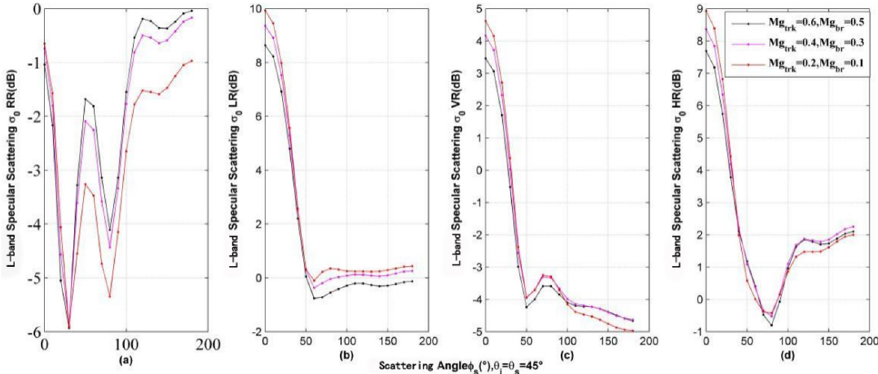
Figure 7. Specular scattering properties of various polarization for different vegetation water contents. ( a ) RR polarization; ( b ) LR polarization; ( c ) VR polarization; ( d ) HR polarization. Table 6. Vegetation water content and permittivity for the three scenarios. Trunk Branch Moisture Permittivity Moisture Permittivity